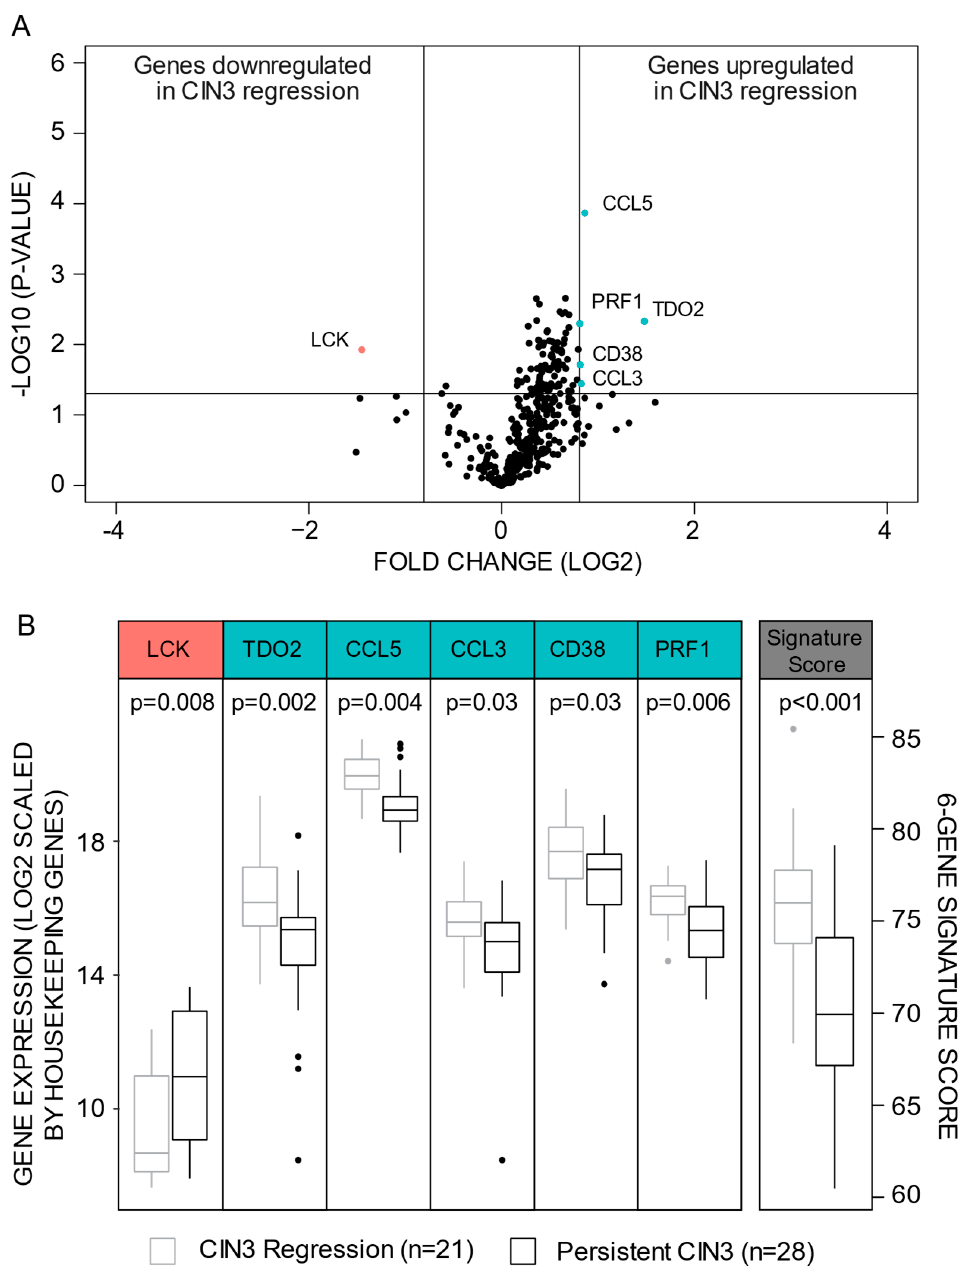
Figure 1. Identification of a CIN regression signature. ( A ) Distribution of differentially expressed genes as defined by the criteria of p < 0.05 and fold change < − 1.75 or >1.75. ( B ) Distribution of log 2 expression levels (scaled by housekeeping genes) of the six signature genes and the signature score in lesions of confirmed CIN3 regression versus persistent CIN3. The Man–Whitney U test was applied when if the distribution of the genes were different in CIN3 Regression versus Persistent CIN3. Abbreviations: CIN: Cervical intraepithelial